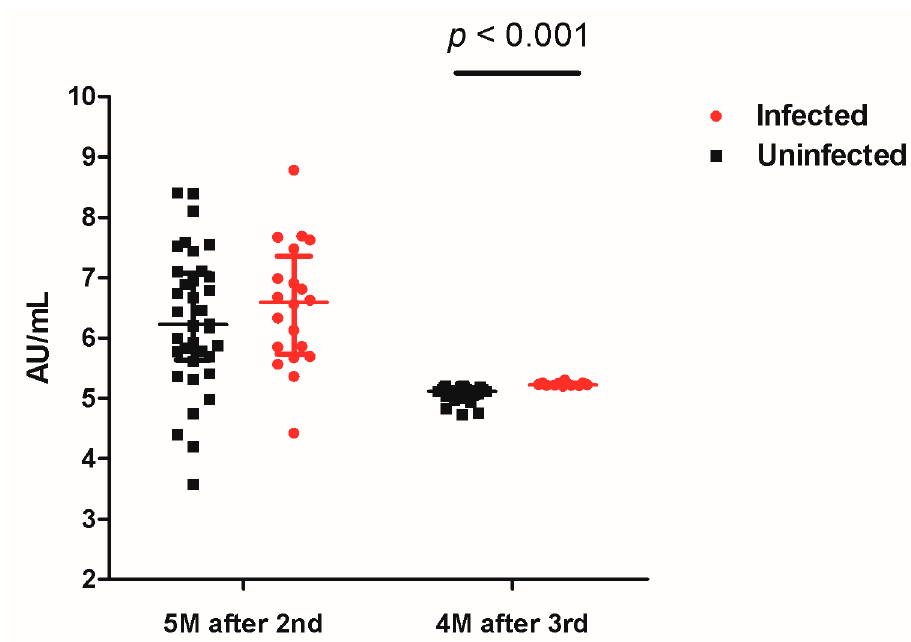
Figure 2. SARS-CoV-2 spike-specific immunoglobulin G (IgG) five months after second-dose vac- cination and four months after booster vaccination in COVID-19-infected and uninfected